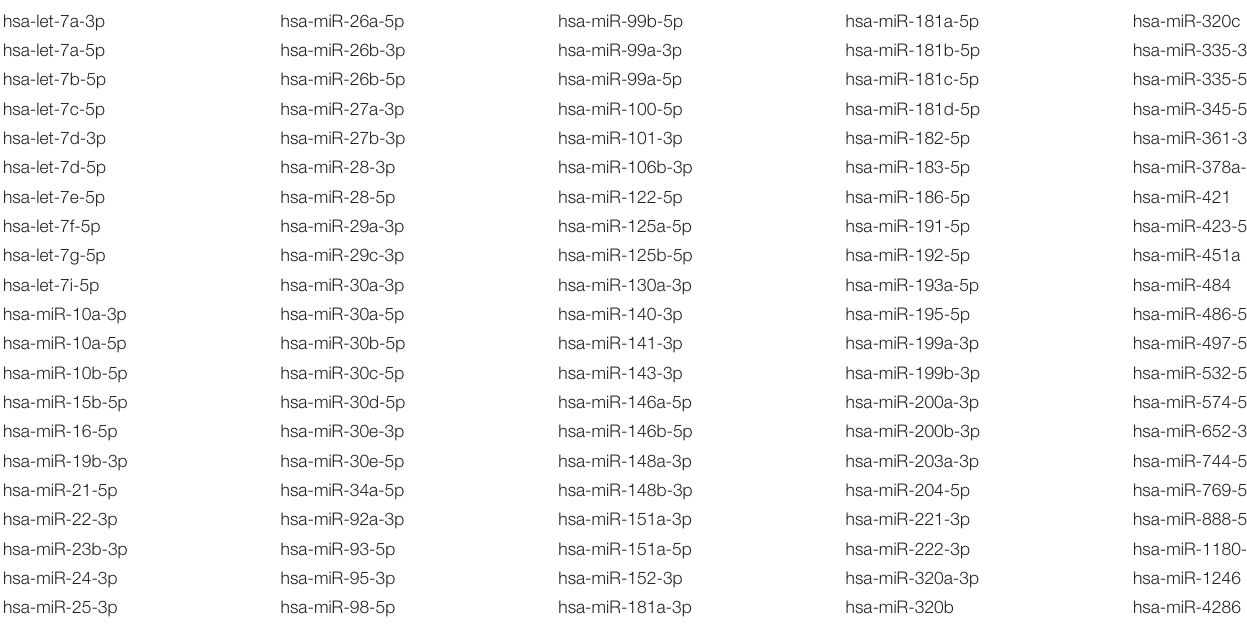
TABLE 2 | List of microRNAs shared between all